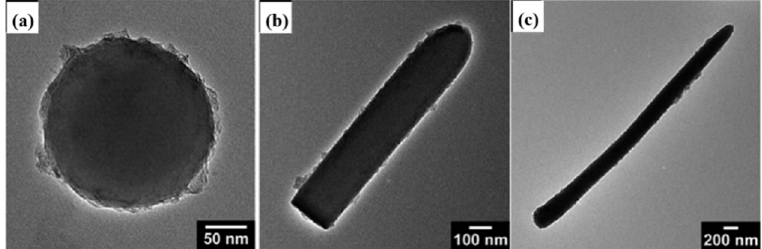
Figure 4. TEM images of GO-wrapped silica sphere ( a ) and GO-wrapped silica spheres rod with an aspect ratio of 5.0 ( b ), rod with an aspect ratio of 20 ( c ) [60].